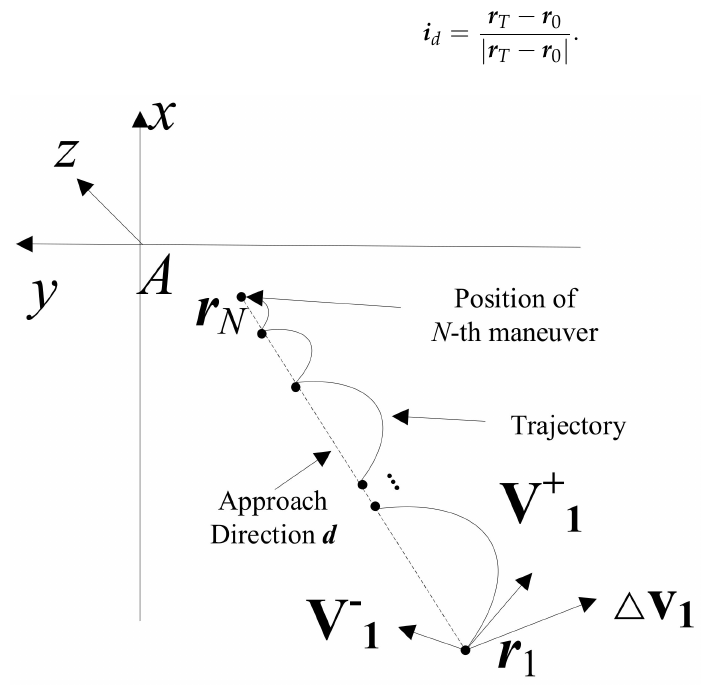
Figure 3. An example of the multipulse glideslope approach